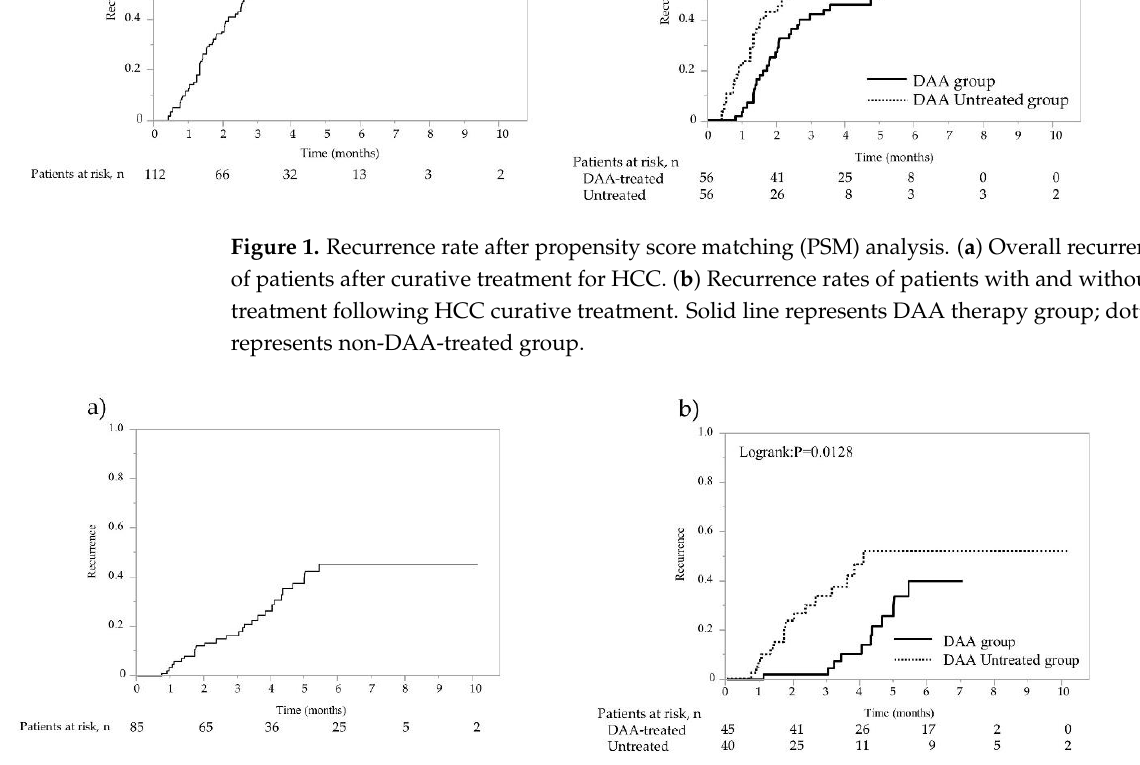
Figure 2. Second recurrence rate after propensity score matching (PSM) analysis. ( a ) Overall second recurrence rate of 85 patients with curative treatment for initial and first recurrent HCC. ( b ) Second recurrence rates of 85 patients with curative treatment for initial and first recurrent HCC. Solid line represents DAA therapy group; dotted line represents non-DAA-treated group. Table 3. Univariate and multivariate analyses of HCC recurrence-free survival after PSM.